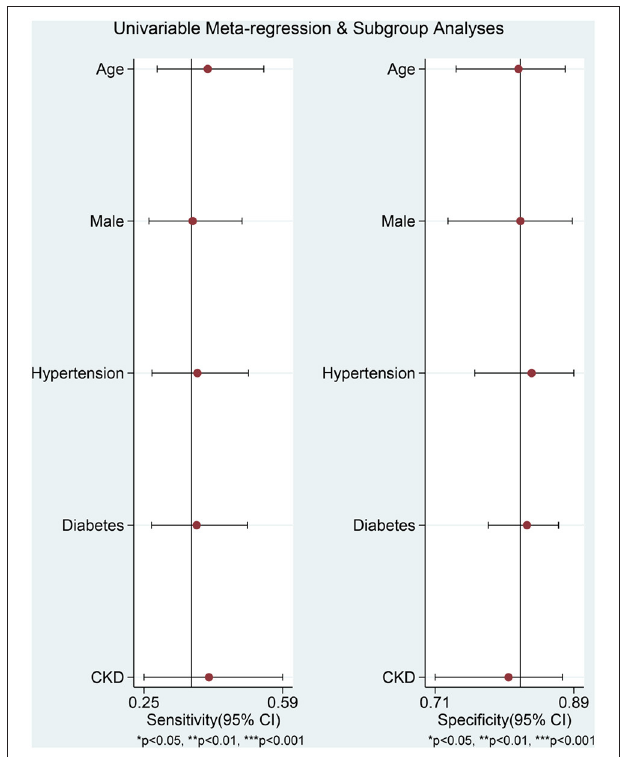
FIGURE 6 | Meta-regression